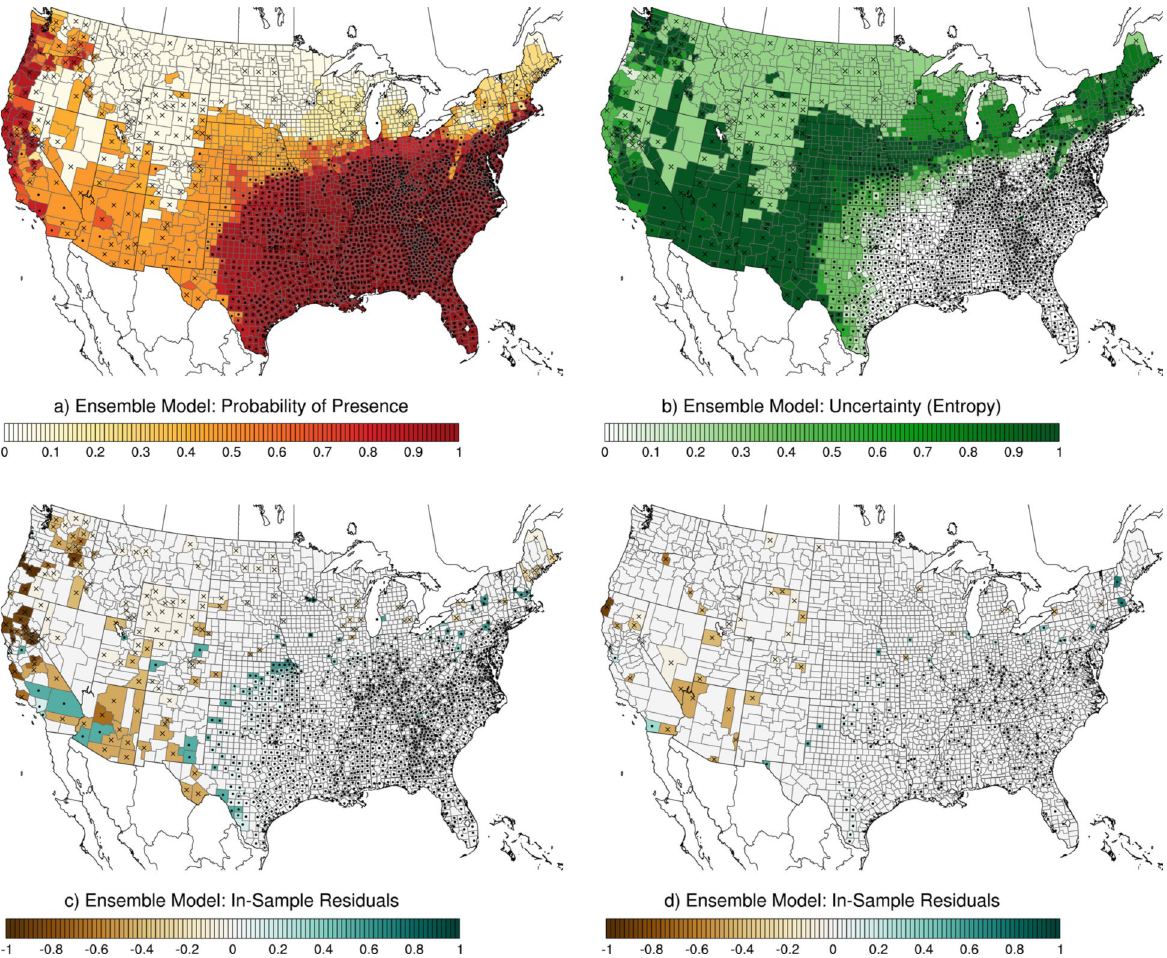
Fig 6. Ensemble model for Ae . albopictus . (a) Ensemble model probability of presence; (b) ensemble model uncertainty expressed as entropy, H ; (c) ensemble model in-sample residuals, E ; and (d) ensemble model out-of-sample residuals, E . Black dots are presence records and black "x" marks are pseudo-absence records. All presence and absence records are shown in (a) and (b); only in-sample records are shown in (c); and only out-of- sample records are shown in